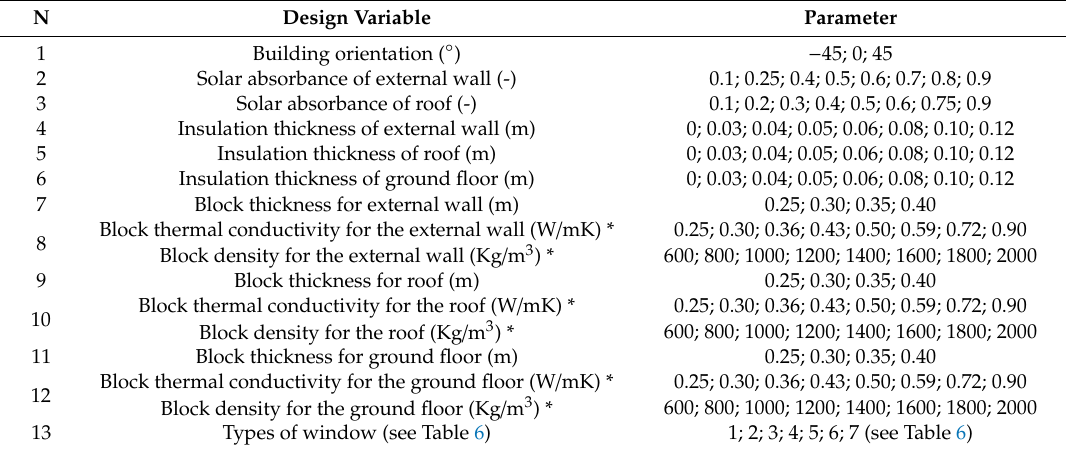
Table 5. Design parameters for reference buildings in each climate zone.